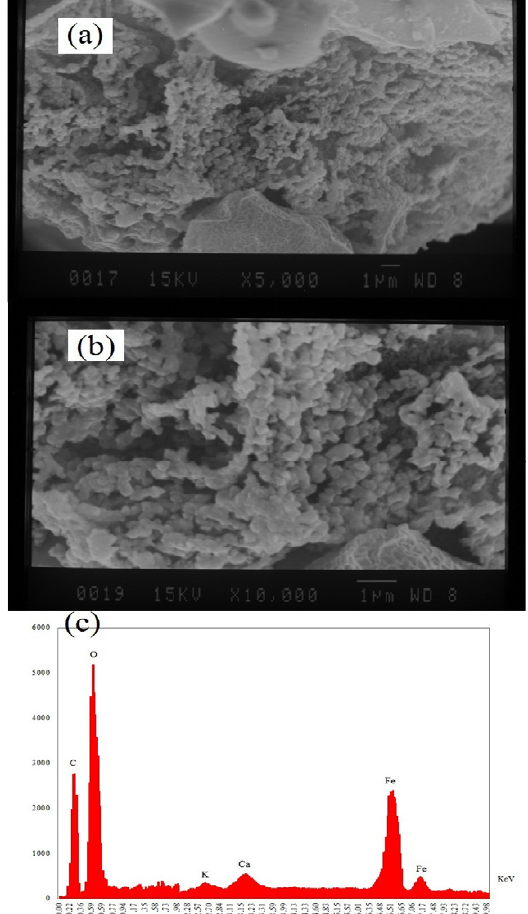
7 Fig. 7. SEM images of Fe 3 O 4 /RGO (a) ×5000, (b)×10000, and (c) EDS spectrum of Fe 3 O 4